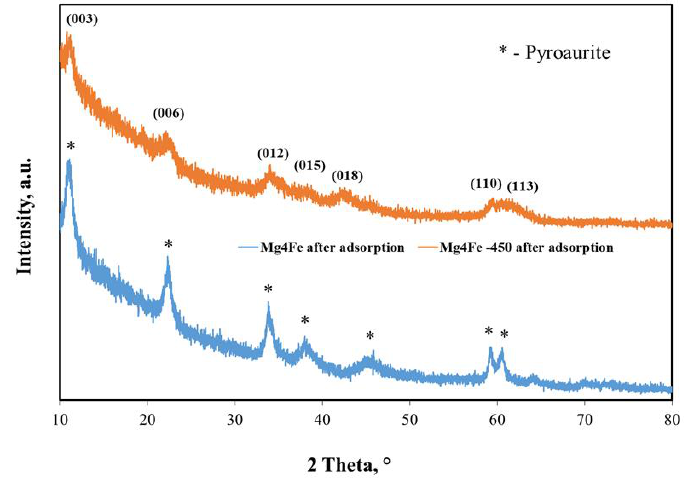
Figure 11. XRD patterns of the materials after Mo(VI) adsorption.